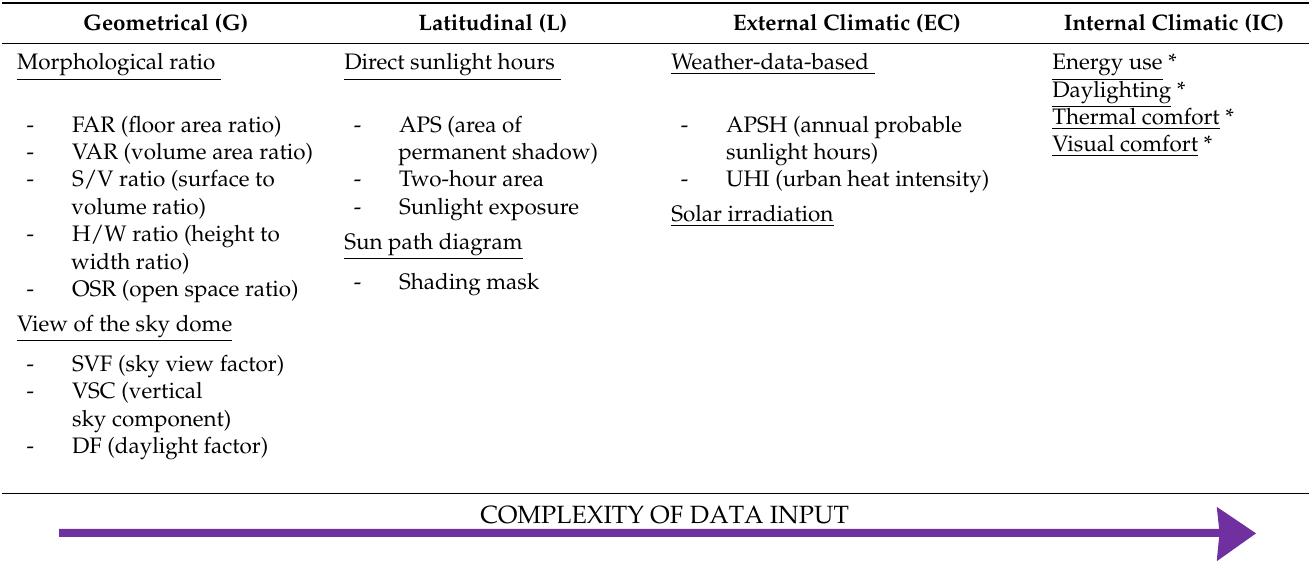
Table 2. Taxonomy of metrics in solar urban design. Metrics were divided in classes: G, L, EC, and IC. Each class consists of metric groups (underlined) and includes a few commonly used metrics that are further discussed in this paper. Other metrics exist but are used less frequently.